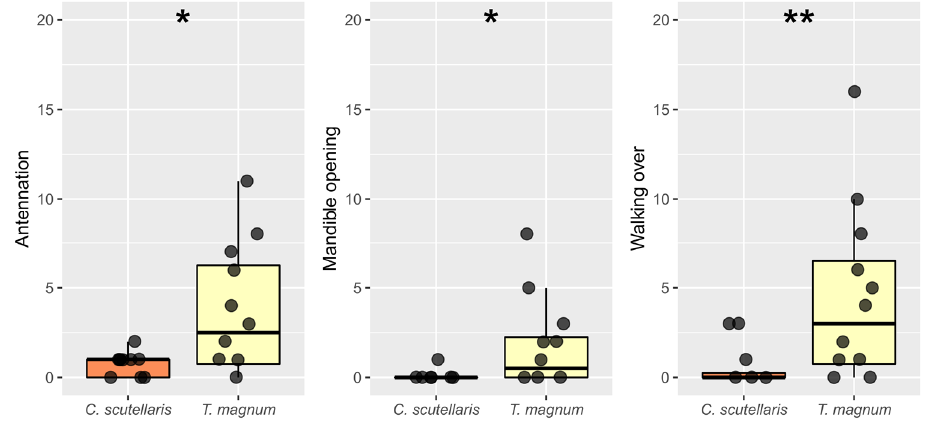
Figure 1. The interactions observed between the ants ( Crematogaster scutellaris and Tapinoma magnum ) and the Cydia pomonella eggs. Asterisks represent the significance level of the differences between the two species (*, p ≤ 0.05; **, 0.001 < p ≤ 0.01).